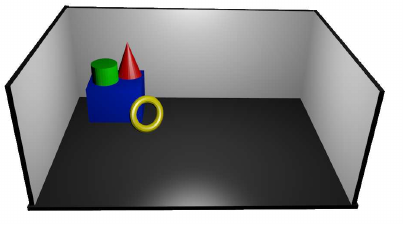
Figure 4: Virtual 3D test environment